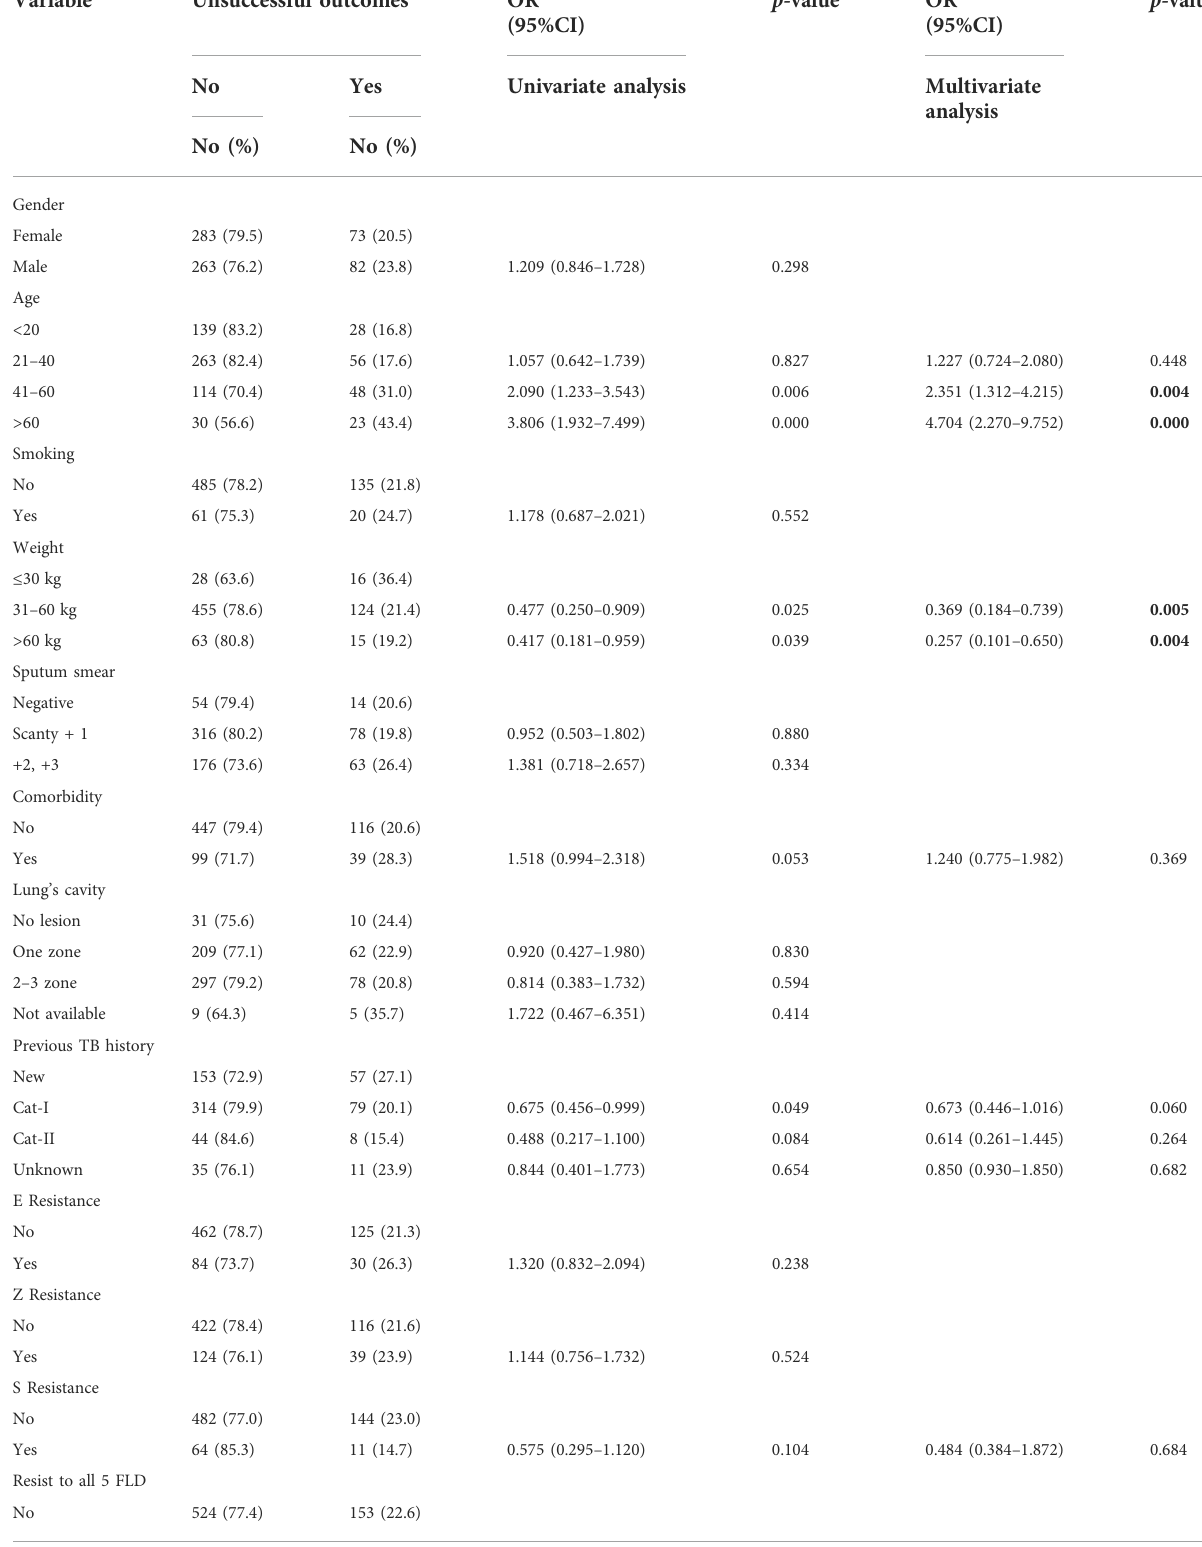
TABLE 4 Risk factors associated with unsuccessful treatment outcomes in MDR-TB